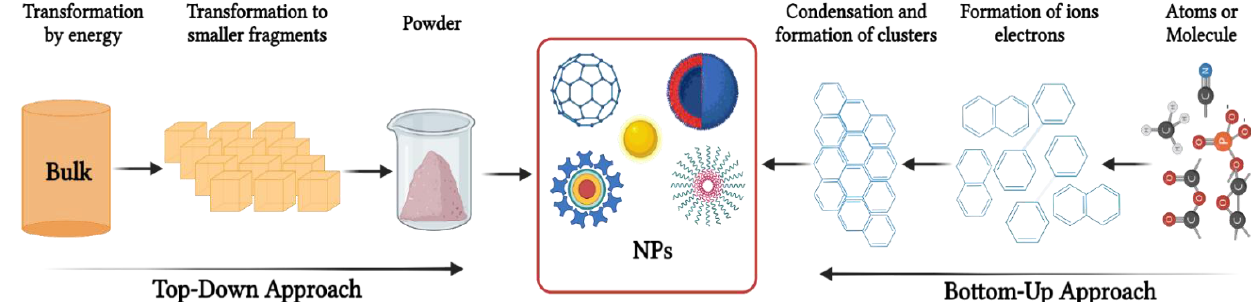
Figure 1. Synthesis of NPs via the bottom-up and top-down approaches. Bulk materials are broken down into small particles using physical methods in the top-down approach, while the bottom-up approach uses wet chemistry to assemble smaller atoms into NPs.